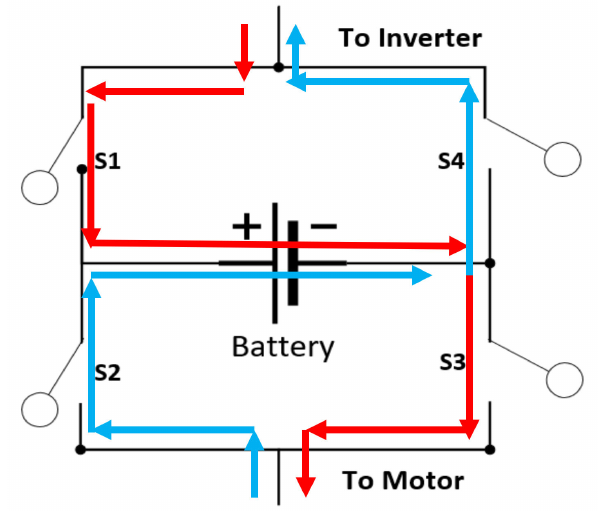
Figure 3. Proposed battery bridge model. Red arrows show positive half cycle switching and blue arrows show negative half cycle switching.